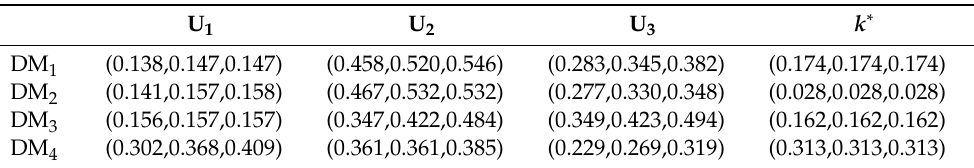
Table 10. The optimal fuzzy